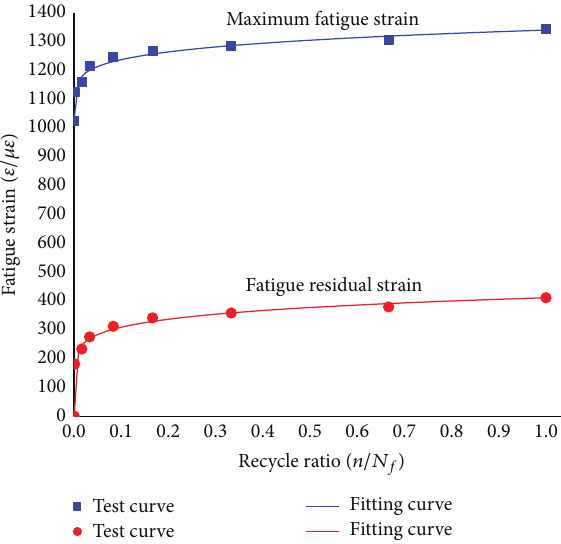
Test curve Test curve Figure 5: Testing and fitting results of fatigue strain of